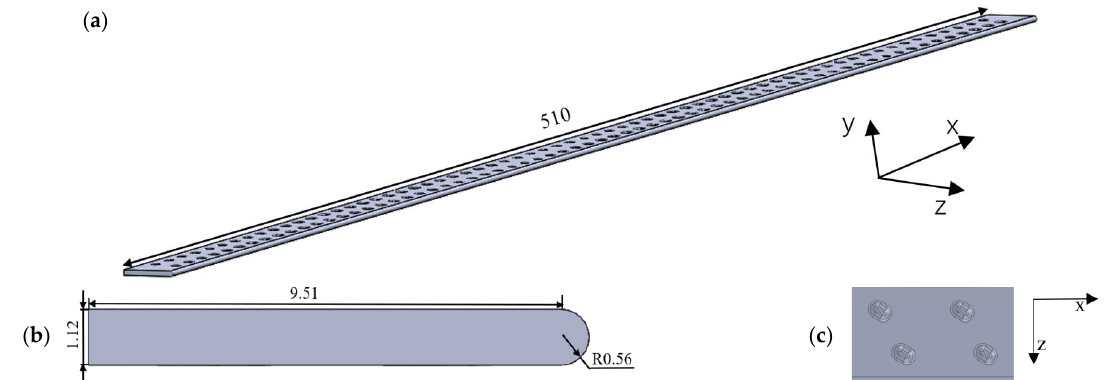
Figure 1. Three-dimensional model of the micro-tube with dimples. Overall model ( a ), transversal surface ( b ) and dimples ( c ). Table 1. Main parameters of the micro-tube with dimples.